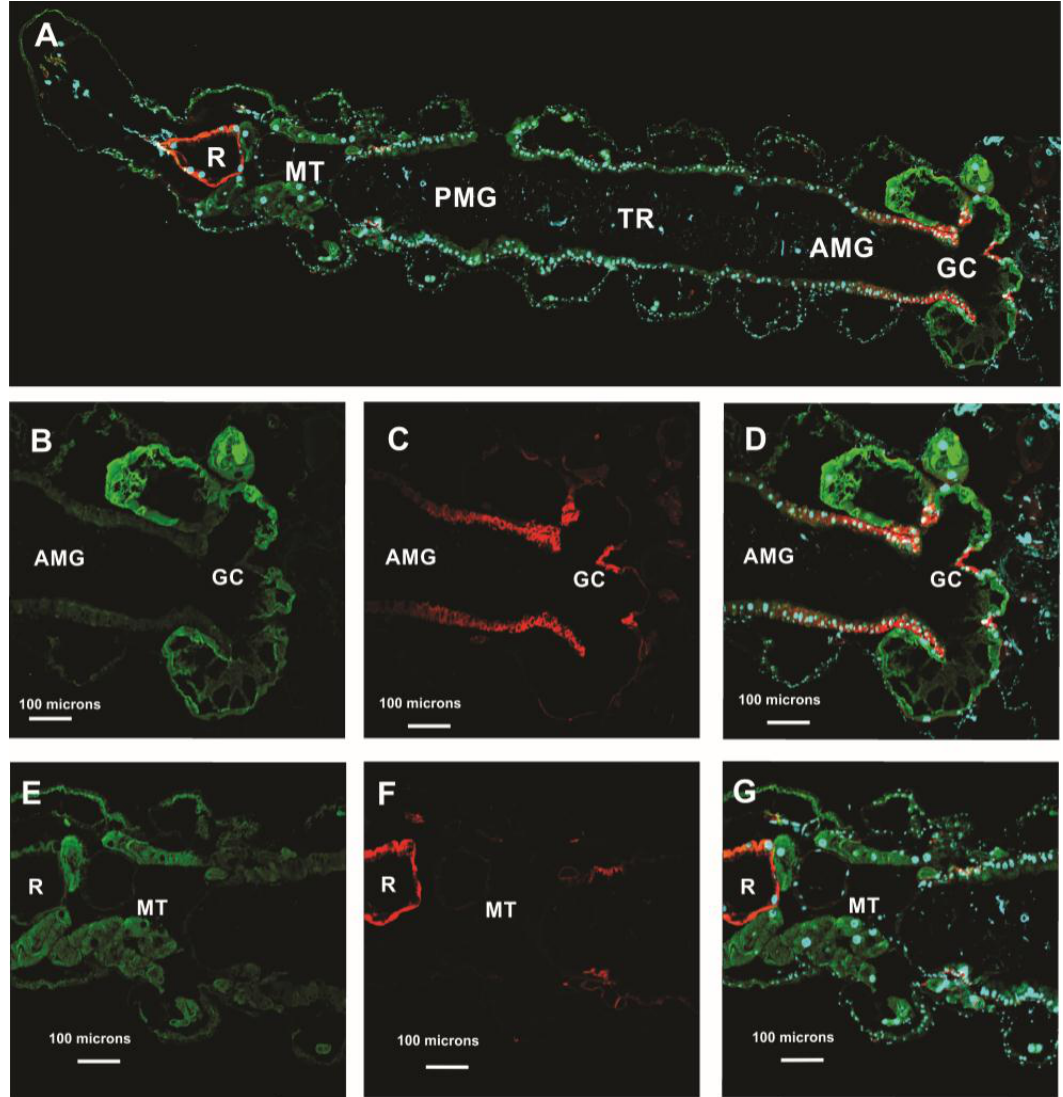
Figure 8. CA9 is compartmentalized to the GC and MTs of Aedes aegypti larvae. This figure shows transverse sections of a 4th instar larvae. The sections were immunostained with antibodies targeting the following: AeCA9 (green), NaK-ATPase (red), and nuclei were counterstained with DAPI (cyan). ( A ) A montage of the entire alimentary canal which is comprised of the following regions: Gastric caeca (GC), Anterior midgut (AMG), transitional region (TR), posterior midgut (PMG), Malpighian tubules (MTs), and rectum (R). In B – D , the GC is either immunostained with AeCA9 ( B ), NaK-ATPase ( C ), or a merge of AeCA9, NaK-ATPase, and DAPI ( D ). In B , AeCA9 is detected in all the cells of the GC except for the cells that make up the stem (arrowhead). AeCA9 is detected in the cap cells (arrow), and the signal for AeCA9 in the caecal lumen (*) is low. In E – G , the MTs are either immunostained with AeCA9 ( E ), NaK-ATPase ( F ), or a merge of AeCA9, NaK-ATPase, and DAPI ( G ). AeCA9 could be detected in the distal MT (arrow with tail), but not as much in the proximal MT (flagged arrow). In both parts of the MTs, signal intensity for AeCA9 is low. There was no immunoreactivity of AeCA9 in the rectum, as was previously demonstrated by Smith et al. 2008 [40]. The scale bars in A–G represent 100 microns.